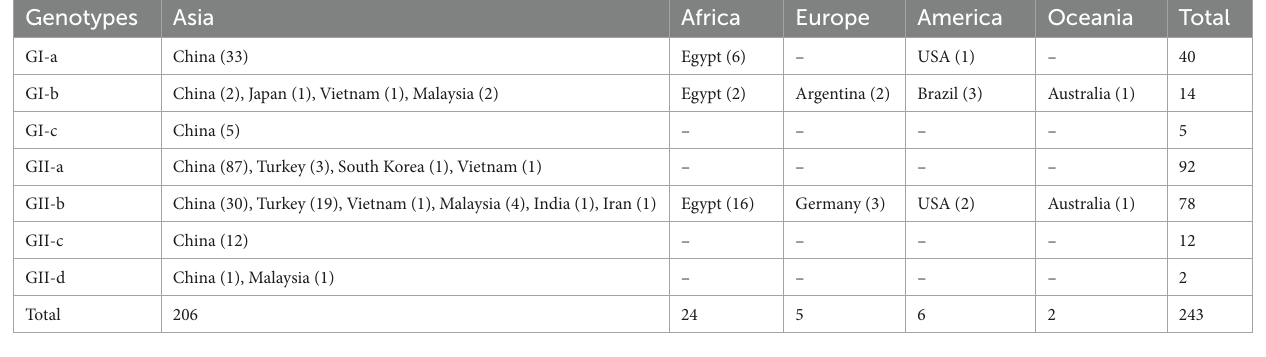
TABLE 1 Geographic distribution of CAV full-length genomes-based genotypes, 1991–2020.